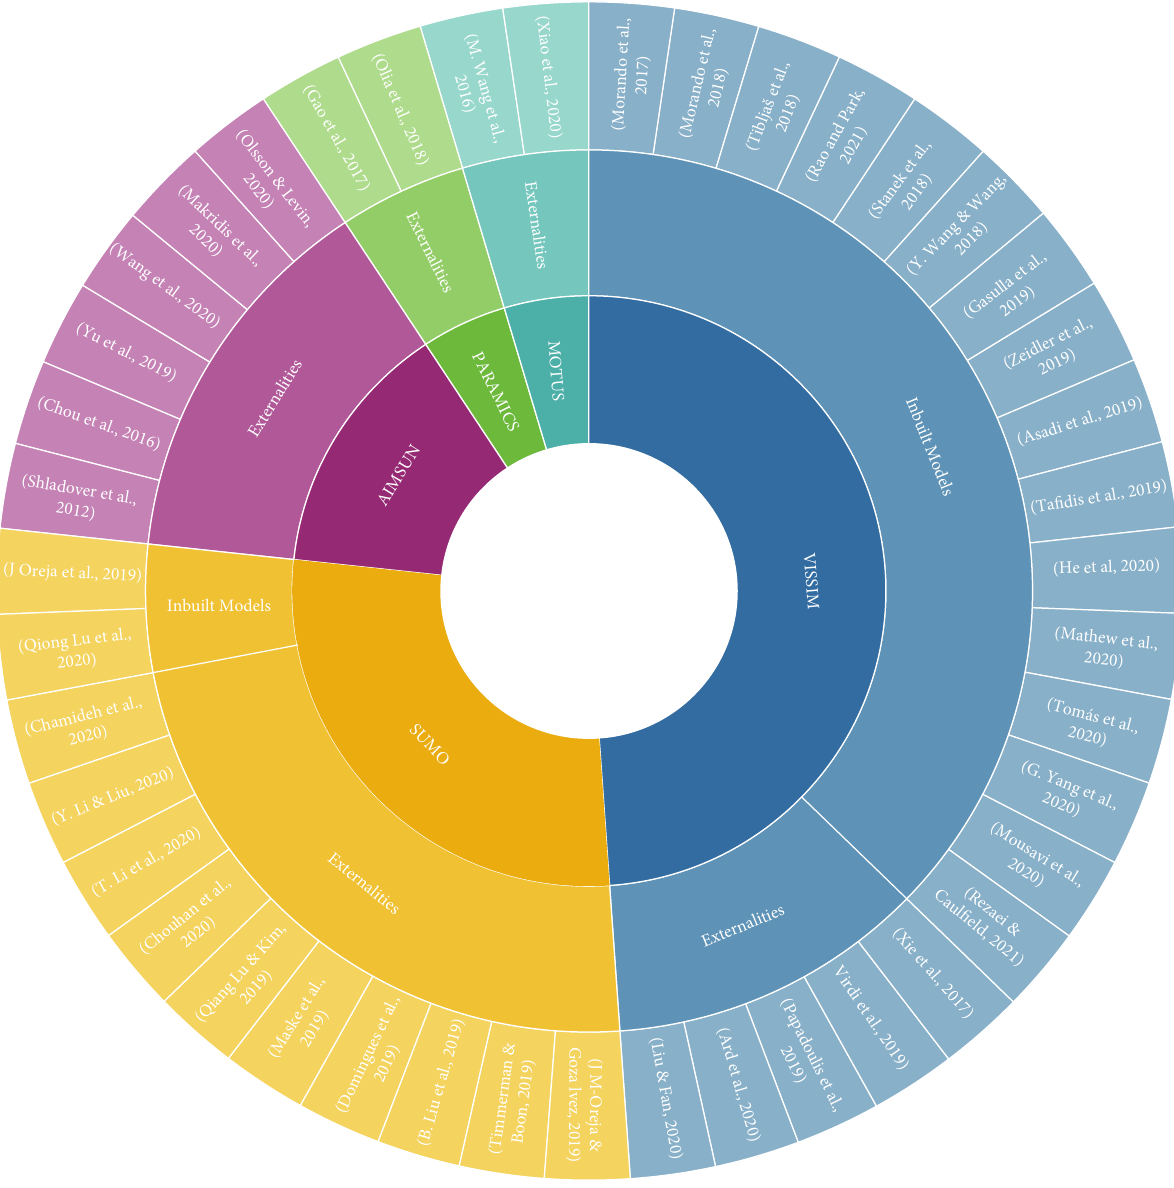
Figure 7: AV microsimulation studies over different